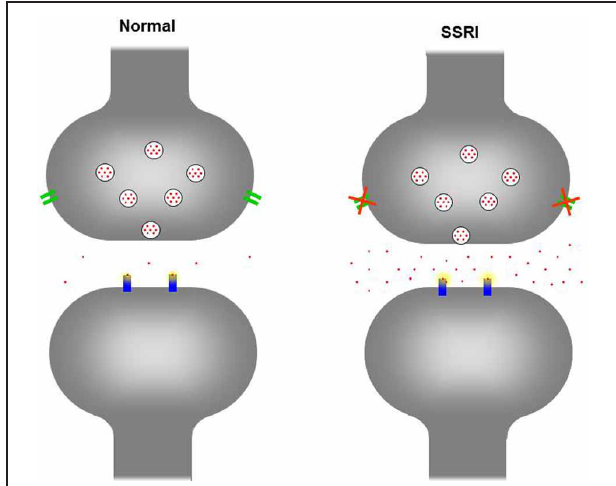
FIGURE 1 | Schematic figure of the serotonergic neuron in a normal situation (left) and when exposed to SSRIs (right). Upon neuronal activation 5-HT (red dots) is being released in the extracellular cleft, activating receptors (blue) at the postsynaptic neuron. To end the signal, excessive 5-HT is being re-uptaken by the serotonin transporter (green) from the extracellular cleft into the presynaptic neuron. In the presynaptic neuron 5-HT is degraded and/or stored in vesicles for future release. In the picture on the right, the serotonin transporter has been blocked by a SSRI and is no longer capable to reuptake 5-HT in the presynaptic neuron, increasing the 5-HT in the extracellular cleft.